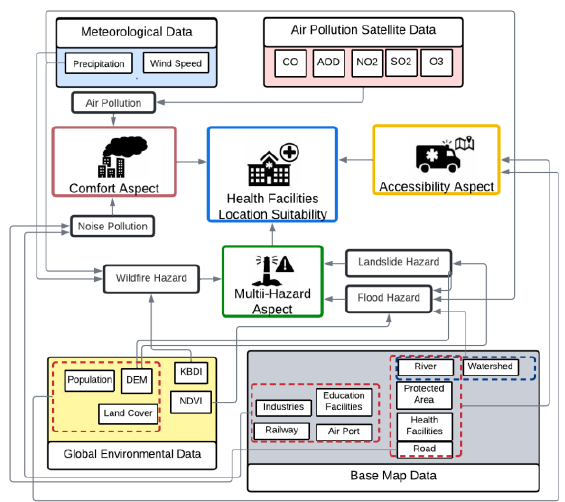
Figure 2 . General Methods